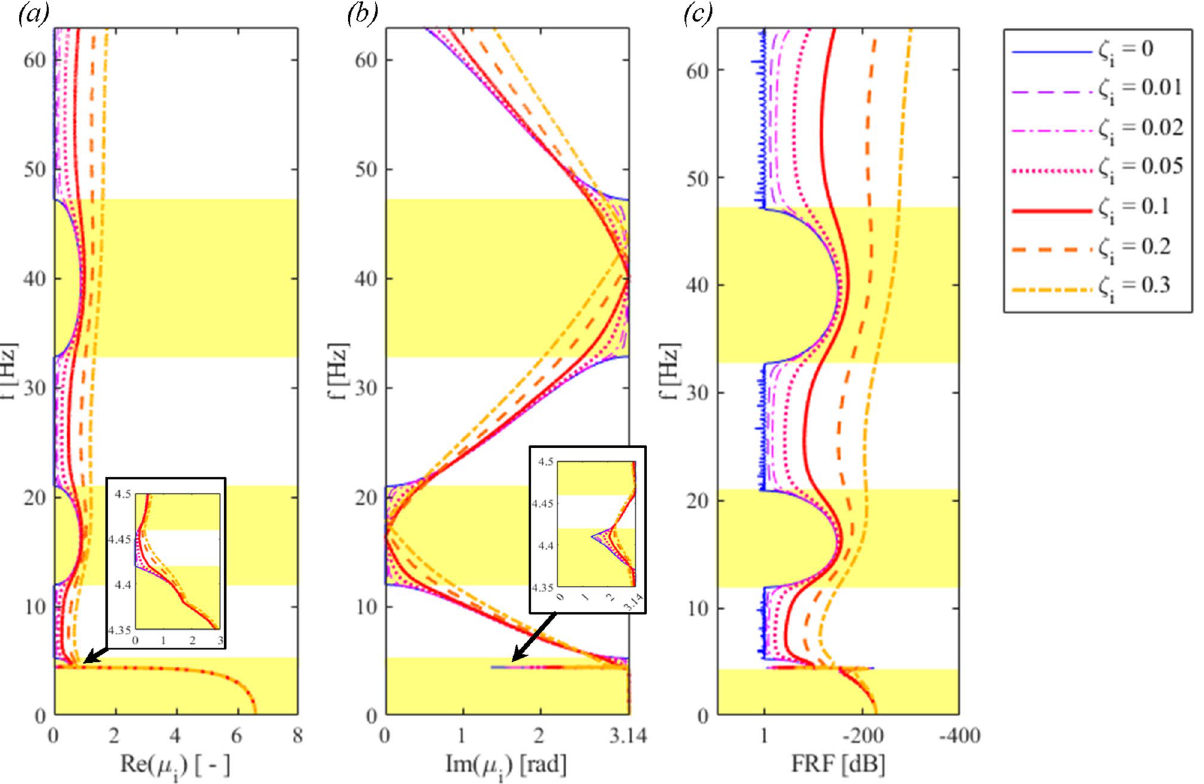
Figure 8. Dispersion curves for an internally damped PPR f : ( a ) real part of μ i , ( b ) imaginary part of μ i ; ( c ) the numerical FRF.